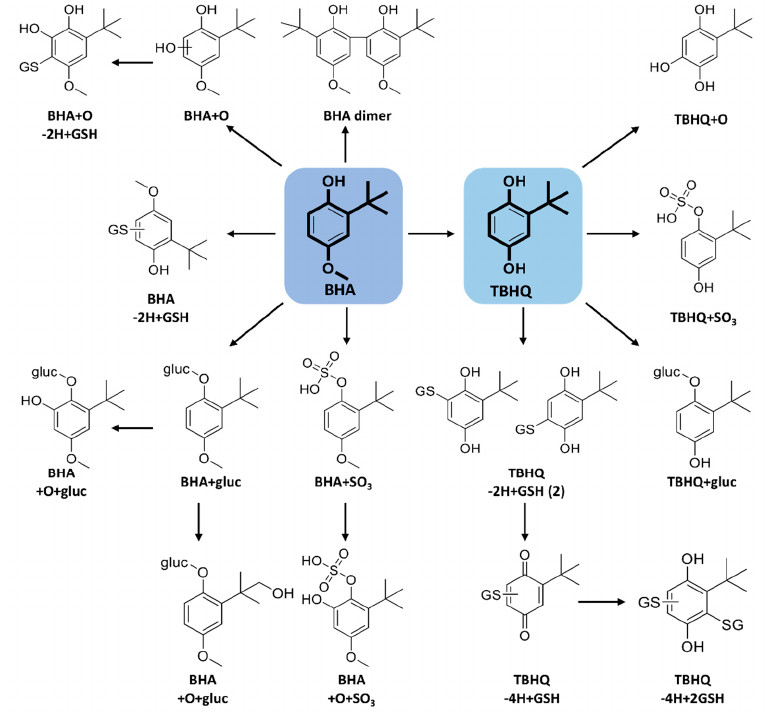
Figure 4. Proposed biotransformation reactions of BHA and TBHQ.